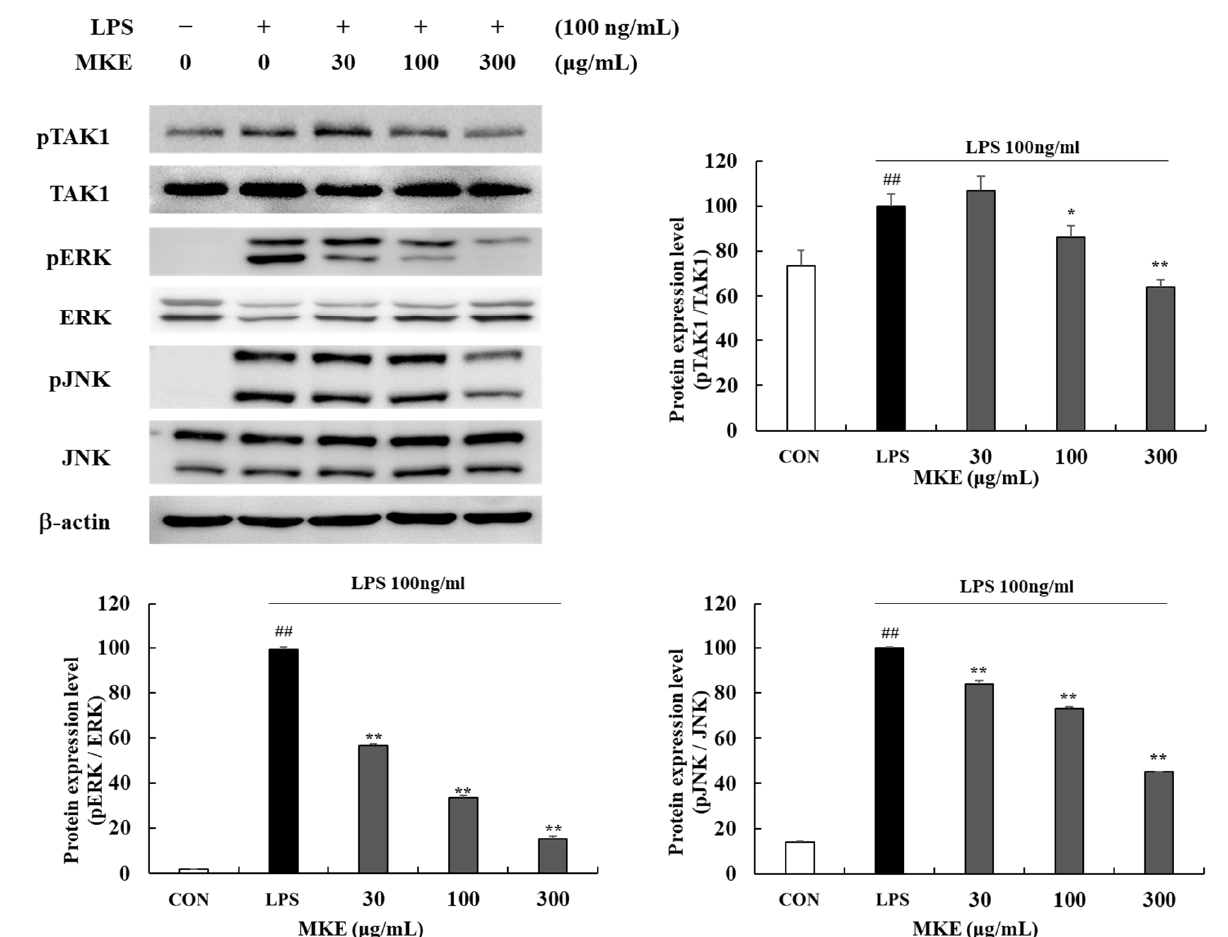
Figure 10. Effects of MKE (30, 100, and 300 μg/mL) on the production of pTAK1 and MAPK factors in LPS-stimulated RAW 264.7 cells. MKE and 100 ng/mL of LPS was added except for in the vehicle control group and incubated at 37 °C for 15 min. Protein expression levels of pTAK1, TAK1, pERK, ERK, pJNK, JNK were detected by Western blot. Values represent as means ± standard deviation. ## p < 0.01 vs. Vehicle control group; * p < 0.05 and ** p < 0.01 vs. LPS-activated control group.